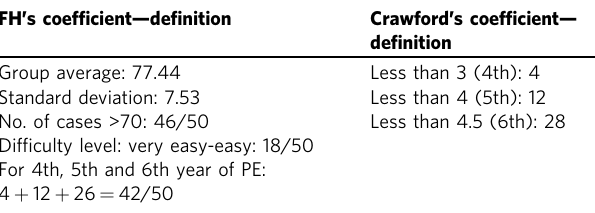
Table 7 Readability of de fi nition and